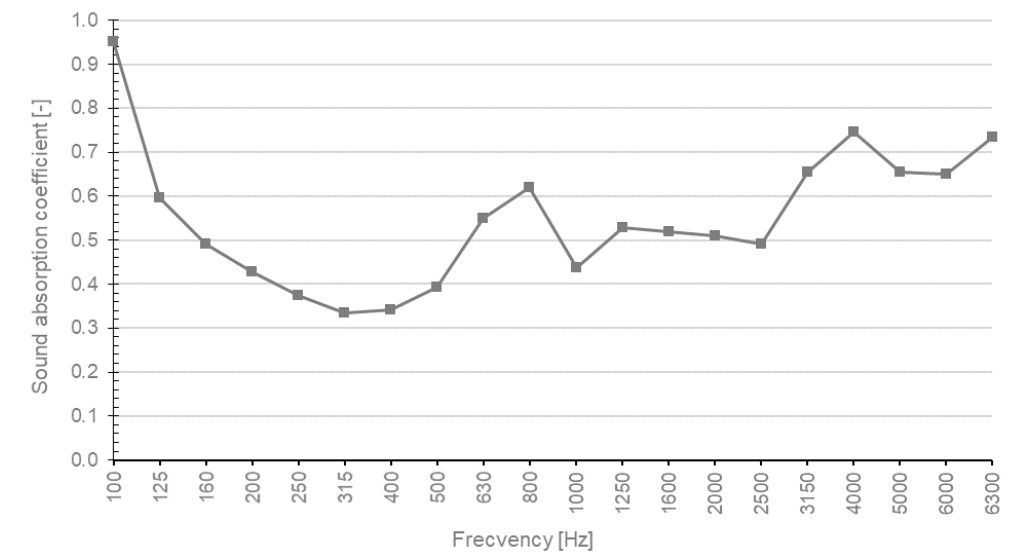
Figure 5. Sound absorption coefficient of hardened lightweight concrete 2.